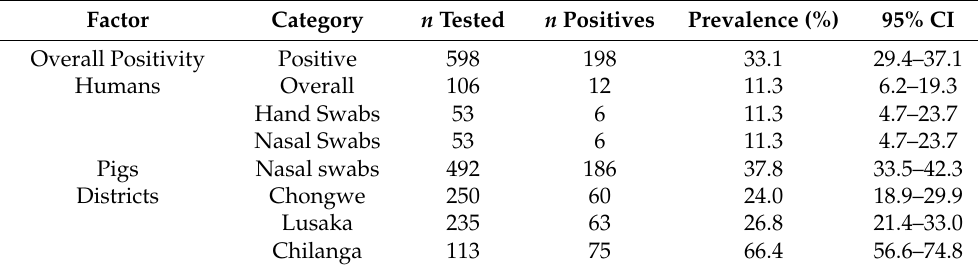
Table 1. S. aureus positivity rates from pigs, humans and districts in Lusaka